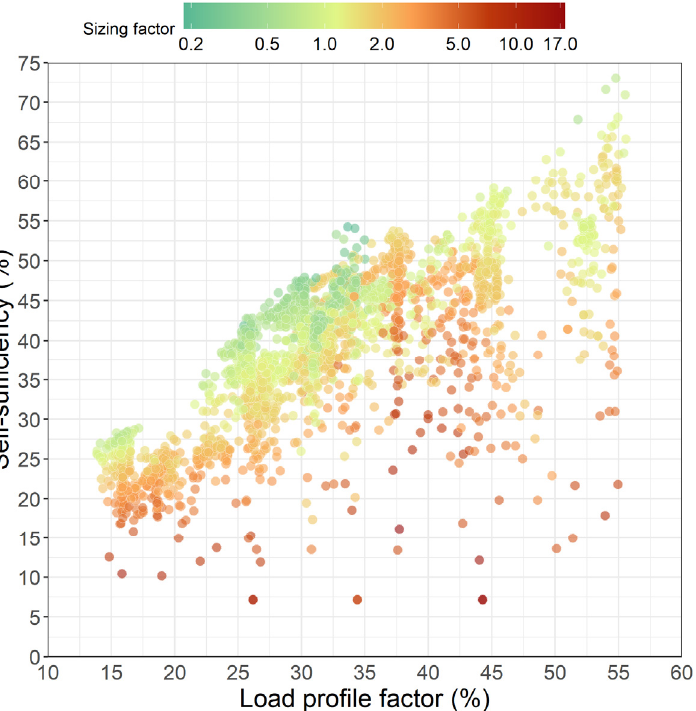
Figure 13. Sca tt er plot of SS and its main predictor variables (load pro fi le factor and sizing factor). Figure 13. Scatter plot of SS and its main predictor variables (load profile factor and sizing factor). The QR expressions are de fi ned in Section 2.3 and the values of the fi tt ed coe ffi cients The QR expressions are defined in Section 2.3 and the values of the fitted coefficients for each variable and building typology are described in Appendix A. for each variable and building typology are described in Appendix